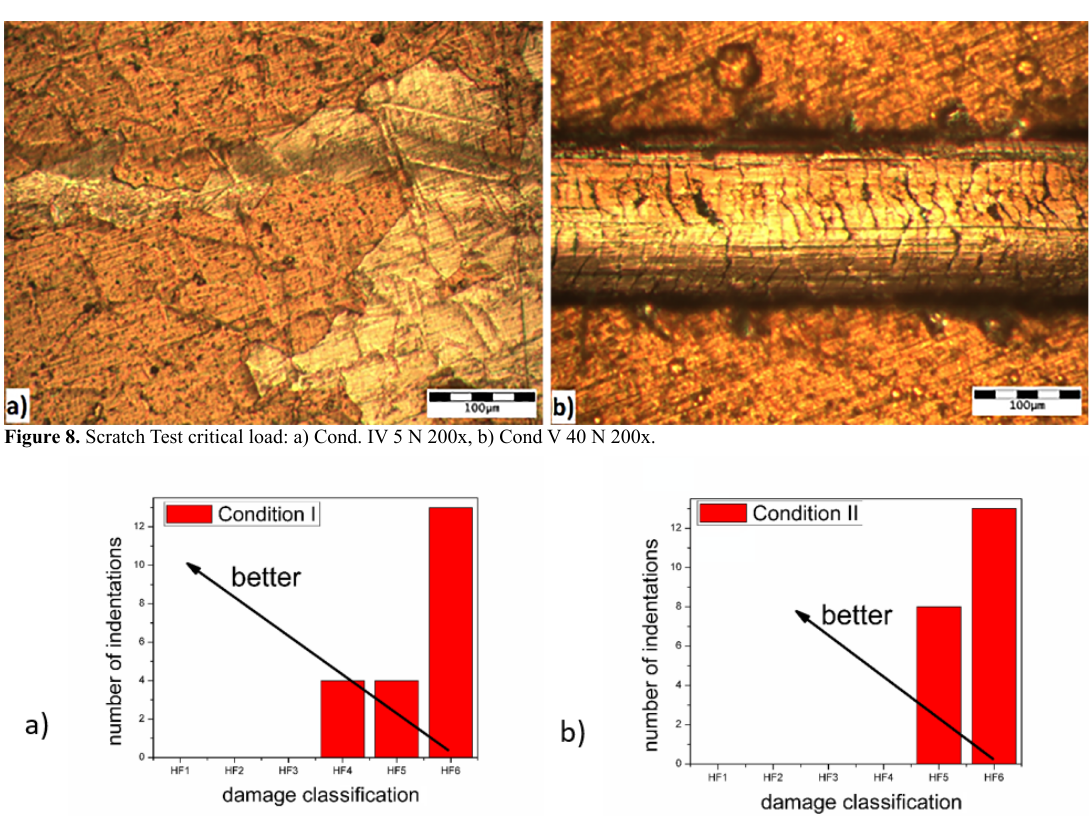
Figure 9. RC Indentation Graphics: a) Condition I, b) Condition